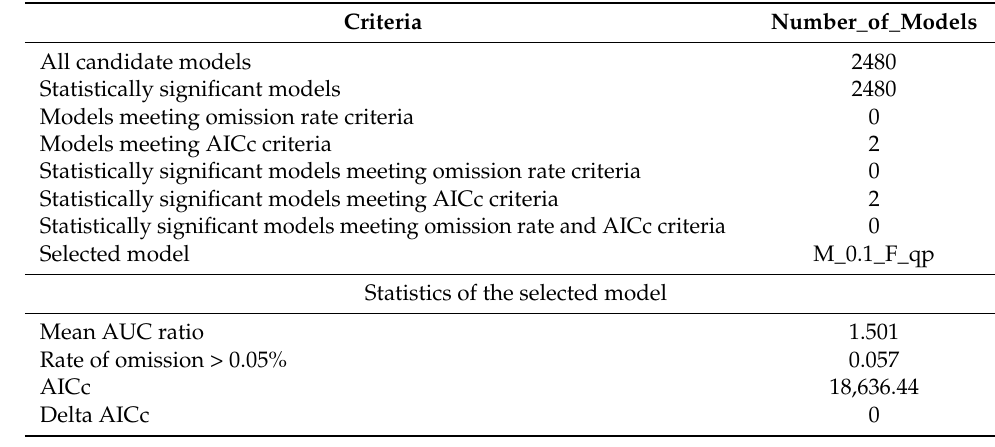
Table 4. Generated and selected candidate models and their fit and validation